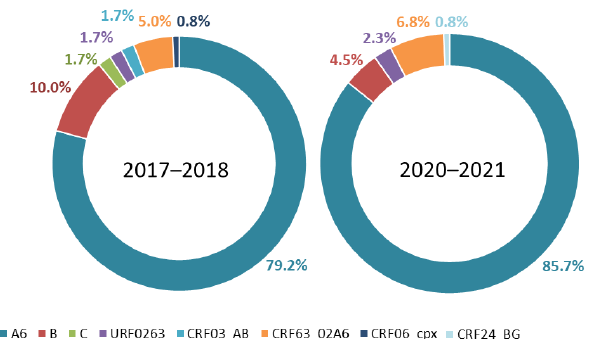
Figure 1. Prevalence of HIV-1 genetic variants in Armenia in the 2017–2018 and 2020–2021 sam- pling years.